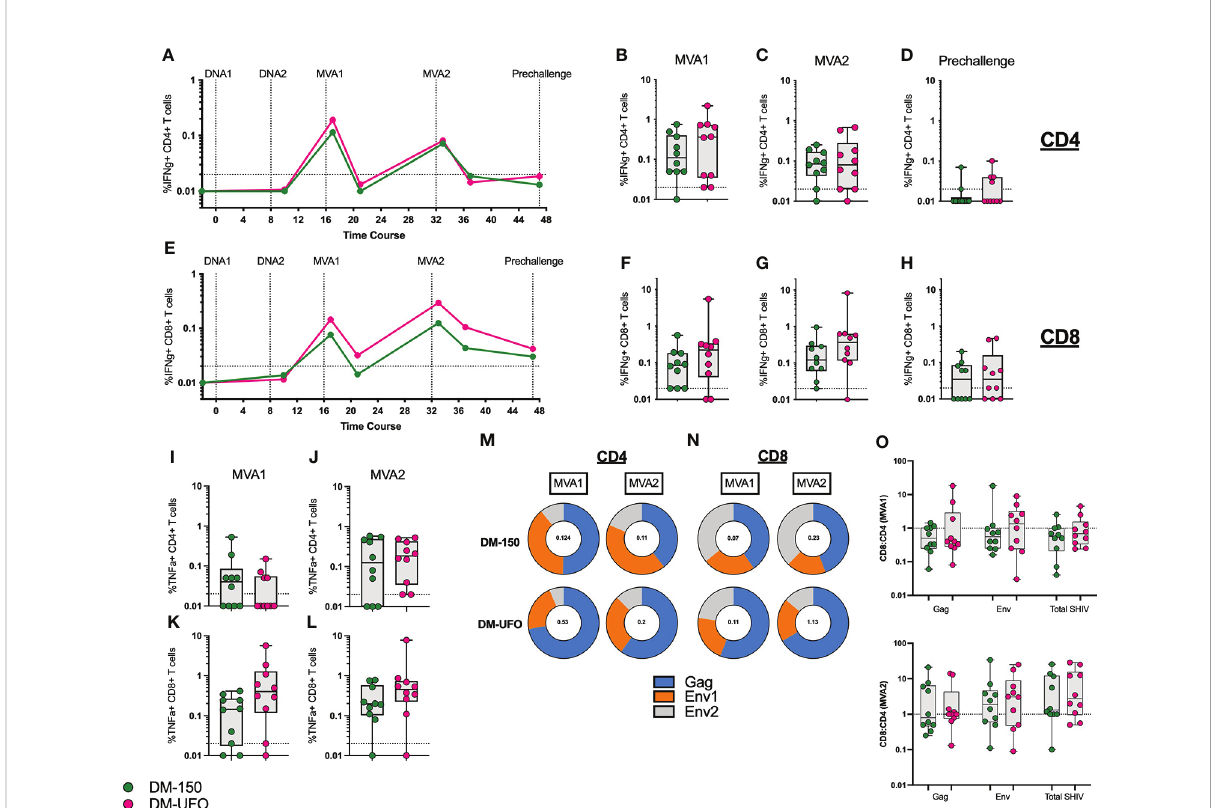
FIGURE 4 ID immunization leads to lower vaccine speci fi c CD4 and CD8 T cell responses. (A) kinetics of the total SHIV speci fi c IFN g + CD4 T cell response. (B) Total SHIV speci fi c IFN g + CD4 T cell response post MVA1. (C) Total SHIV speci fi c IFN g + CD4 T cell response post MVA2. (D) Total SHIV speci fi c IFN g + CD4 T cell response at prechallenge. (E) Kinetics of the total SHIV speci fi c IFN g + CD8 T cell response. (F) Total SHIV speci fi c IFN g + CD8 T cell response post MVA1. (G) Total SHIV speci fi c IFN g + CD8 T cell response post MVA2. (H) Total SHIV speci fi c IFN g + CD8 T cell response at prechallenge. (I) Total SHIV speci fi c TNF a + CD4 T cell response post MVA1. (J) Total SHIV speci fi c TNF a + CD4 T cell response post MVA2. (K) Total SHIV speci fi c TNF a + CD8 T cell response post MVA1. (L) Total SHIV speci fi c TNF a + CD8 T cell response post MVA2. (M) Contribution of the SIV Gag, HIV Env1, and Env2 individual responses to the total IFN g + CD4 T cell response at MVA1 and MVA2. (N) Contribution of the SIV Gag, HIV Env1, and Env2 individual responses to the total IFN g + CD8 T cell response at MVA1 and MVA2. (O) Ratio of CD8 to CD4 total SHIV cytokine responses post MVA1 and MVA2. Green indicates DM-150 and magenta indicates